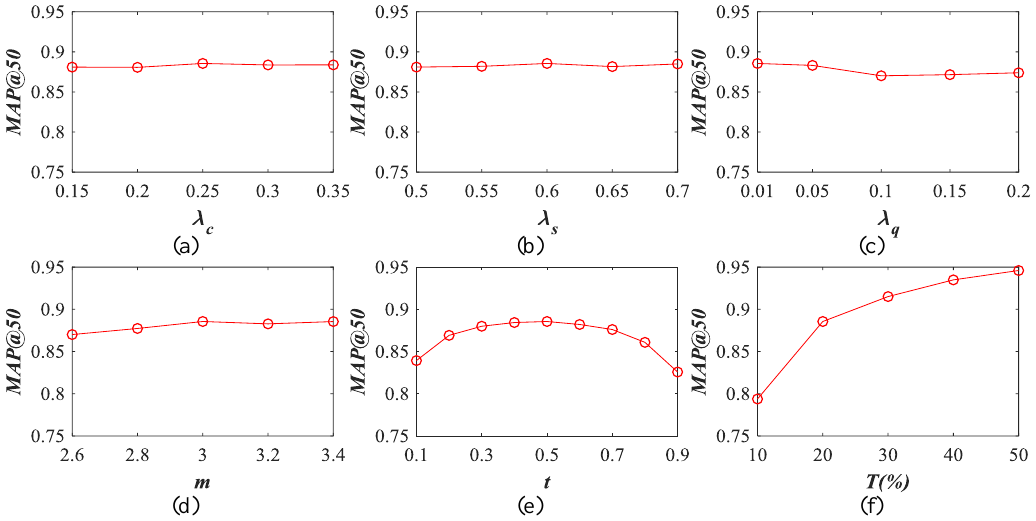
Figure 22. Influence of different parameters on our hash learning model. The results are counted on the NWPU dataset using the 128 bits hash codes: ( a ) λ c ; ( b ) λ s ; ( c ) λ q ; ( d ) m ; ( e ) t ; and ( f ) T